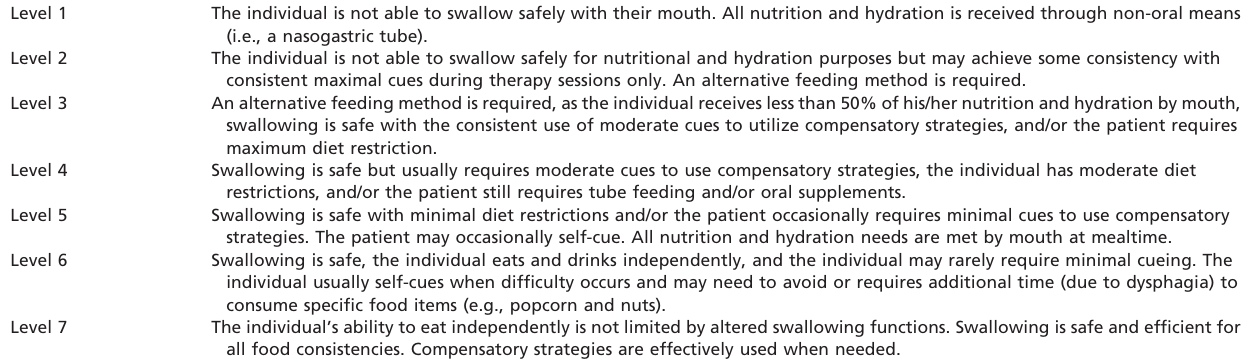
Table 1 - ASHA NOMS swallowing level